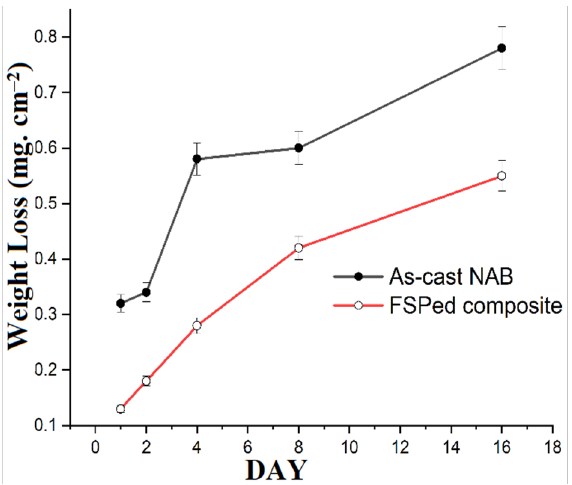
Figure 14. Weight loss in as-cast NAB and FSPed composite specimens after conducting static immersion tests in 3.5% NaCl solution.